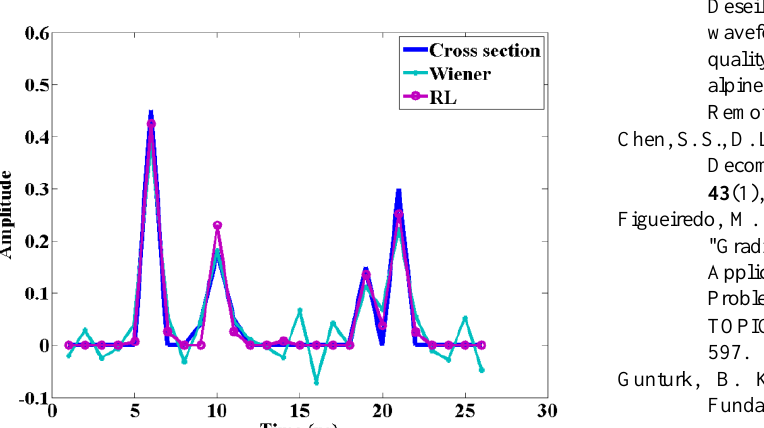
Figure 8. Reconstructed cross sections from BPDN and LASSO for data sample 2